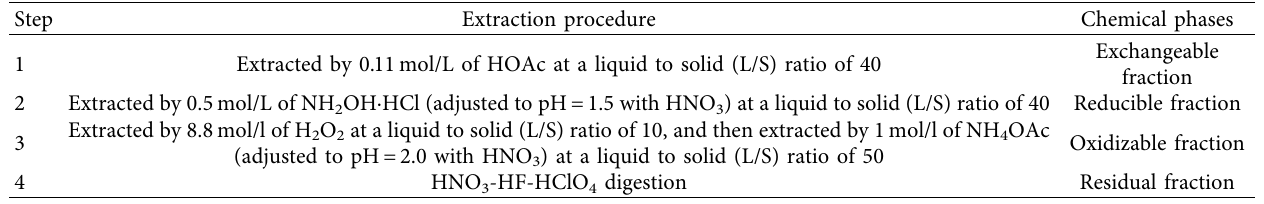
Table 4: Sequential extraction procedure.